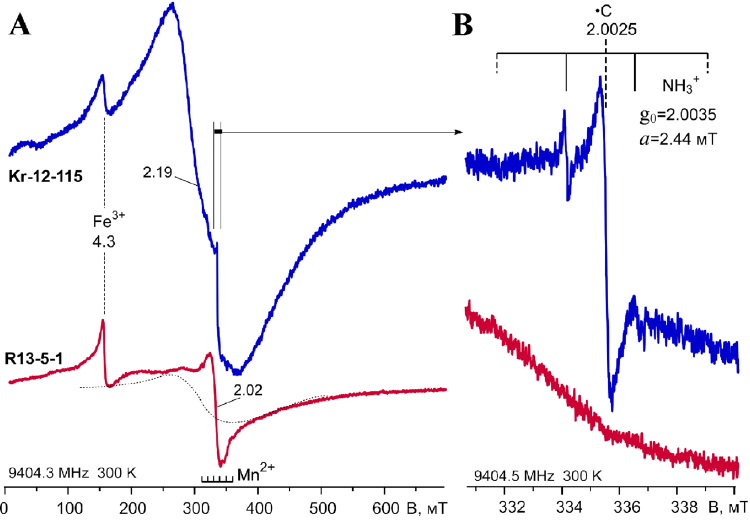
Figure 8. ESR spectra of impact glasses from the Kara astrobleme (upper spectrum) and Ries crater (bottom spectrum): A – the full range spectra; B – magnified part region of g = 2.00. Power of the microwave field is 35 and 7 mW for A and B). The spectra of samples are reduced to the same registration